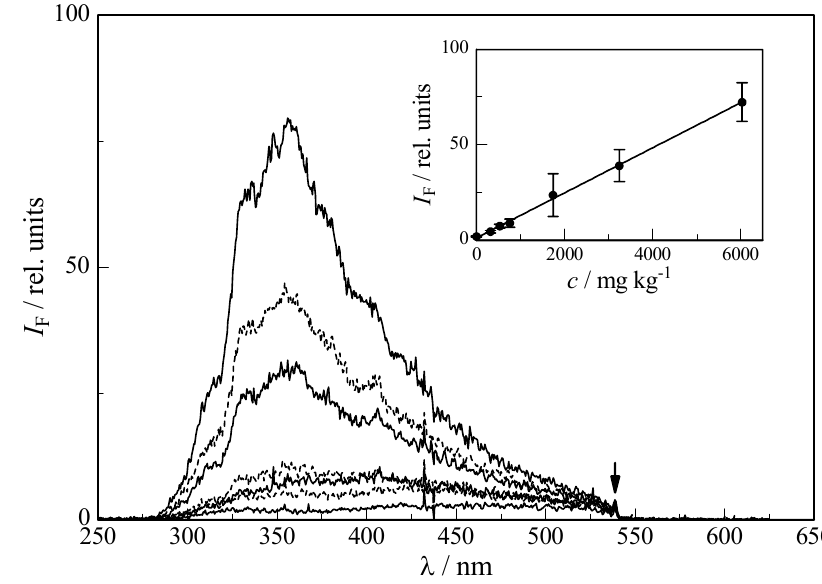
Figure 4. LIF spectra of hydraulic oil 4 on the brown soil ( λ The inset shows calibration data for two independently spiked soil series ( λ obtained from integrated